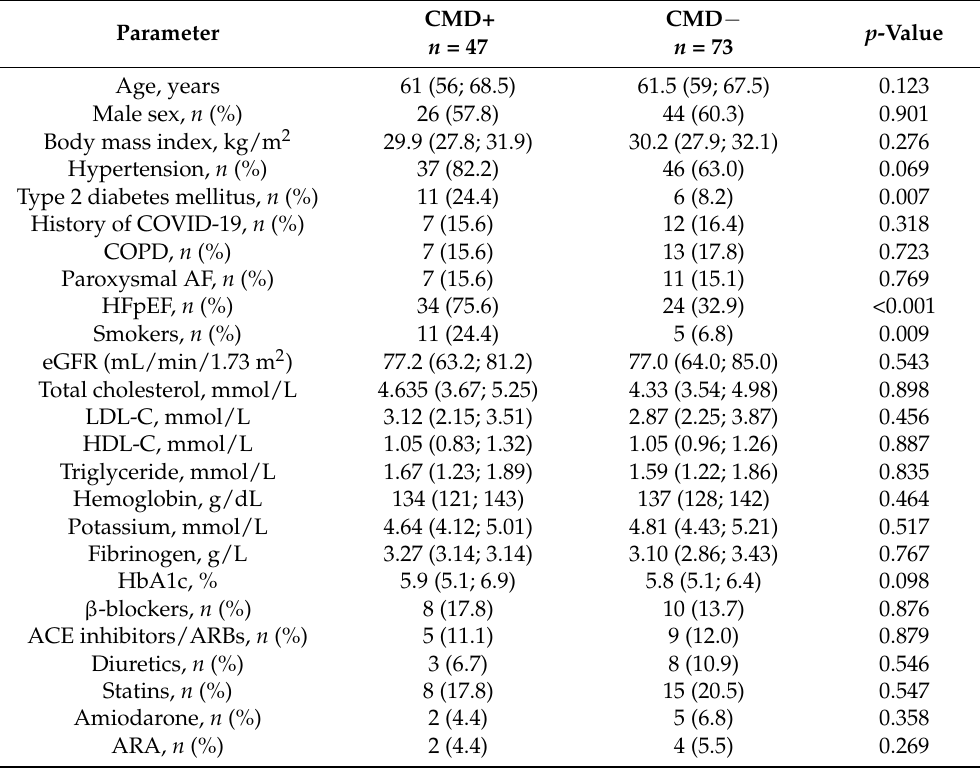
Table 1. Baseline clinical and demographic characteristics of